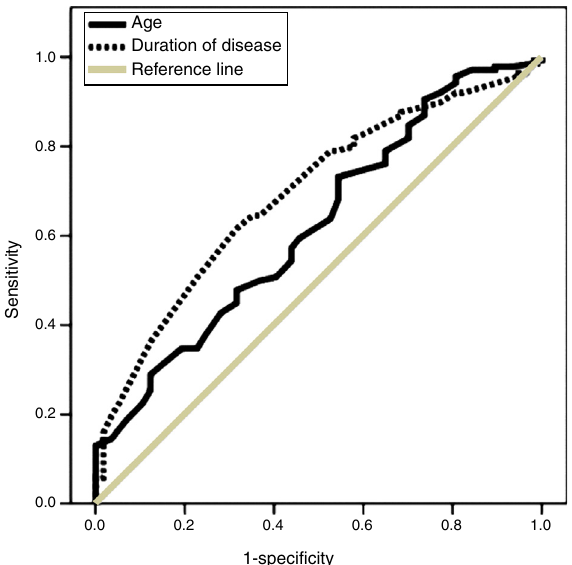
Figure 3 Receiver operator characteristics’ curves of patients’ age and disease duration in predicting unfavorable hearing function six months after treatment. Area under the curve: 0.62 for age and 0.69 for disease duration ( p = 0.01 and <0.001,